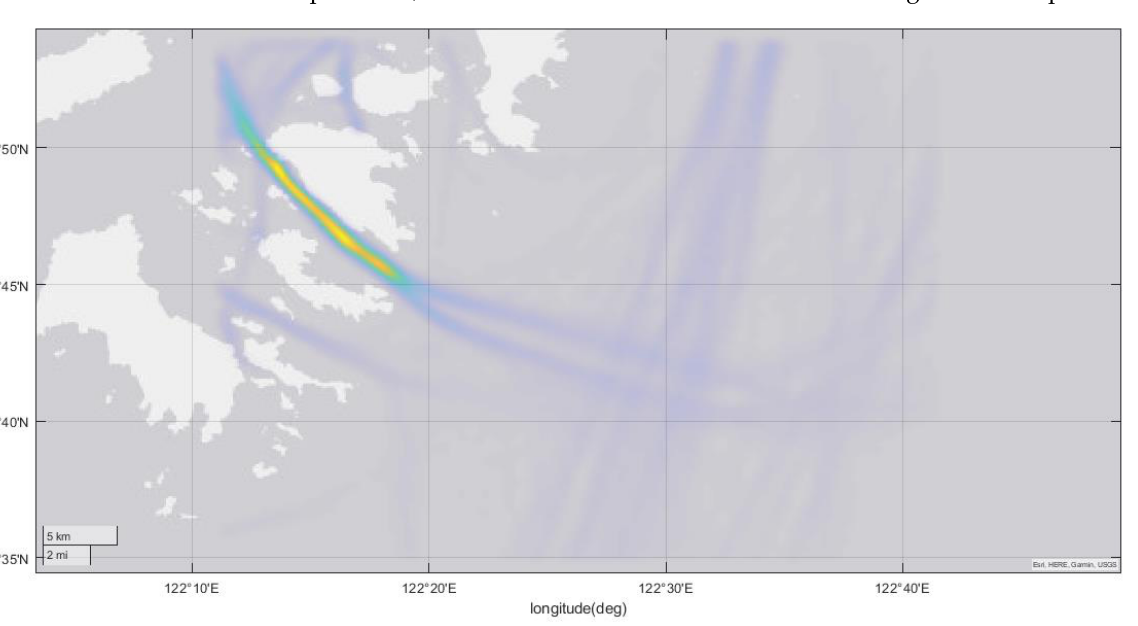
Figure 5. A head-on case based on AIS data. Due to communication and instrument reasons, data missing or errors frequently occur in the AIS data, so it is necessary to clean and interpolate the data. Multi-ship encounter situations cannot be identified because time data is not at the same time. Because the navigation elements do not change much, the data is processed by the linear